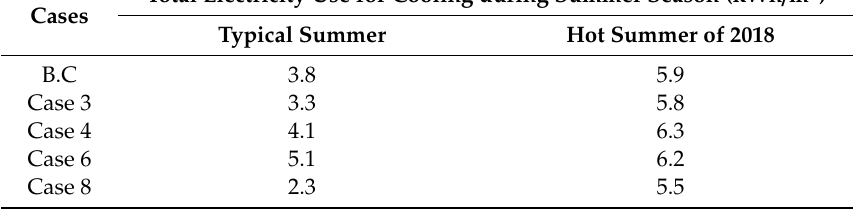
Table 10. The total electricity use for cooling (kWh / m 2 ) during summer season in cases with di ff erent schemes of o ffi ces’ doors with NV plus active cooling for COP = 3 and the maximum beneficial NVR = 0.5 × 1.66